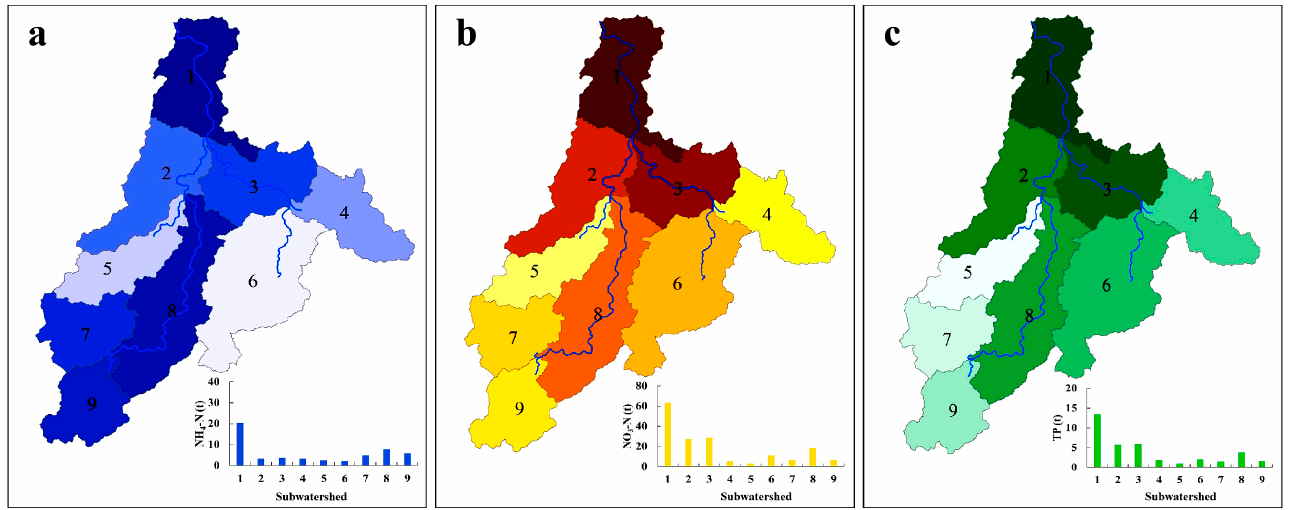
Figure 3. Simulation results of the NH 4 -N, NO 3 -N, and TP loads in tea plantations at the watershed scale based on the SWAT model. Note: ( a – c ) show the distribution characteristics of ammonia nitrogen (NH 4 -N), nitrate nitrogen (NO 3 -N), and total phosphorus (TP) in each subwatershed.